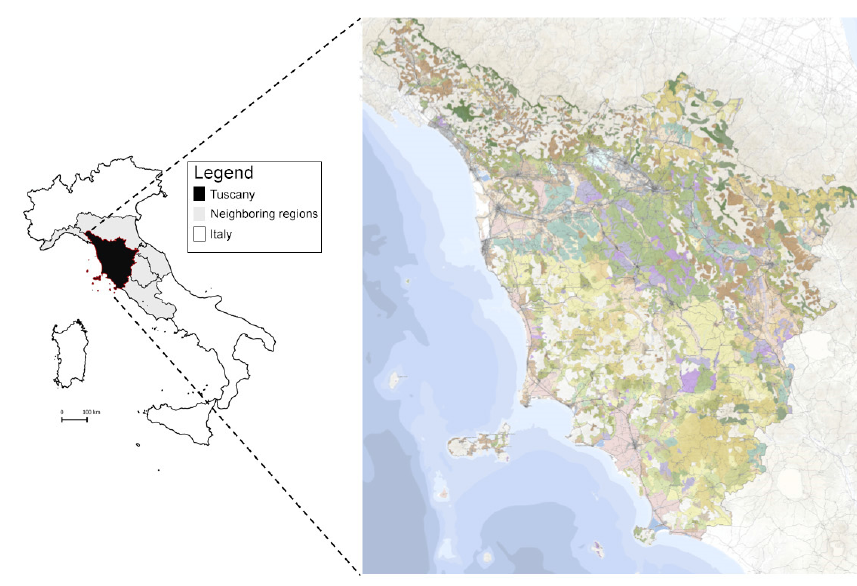
Figure 1. Case study area map.